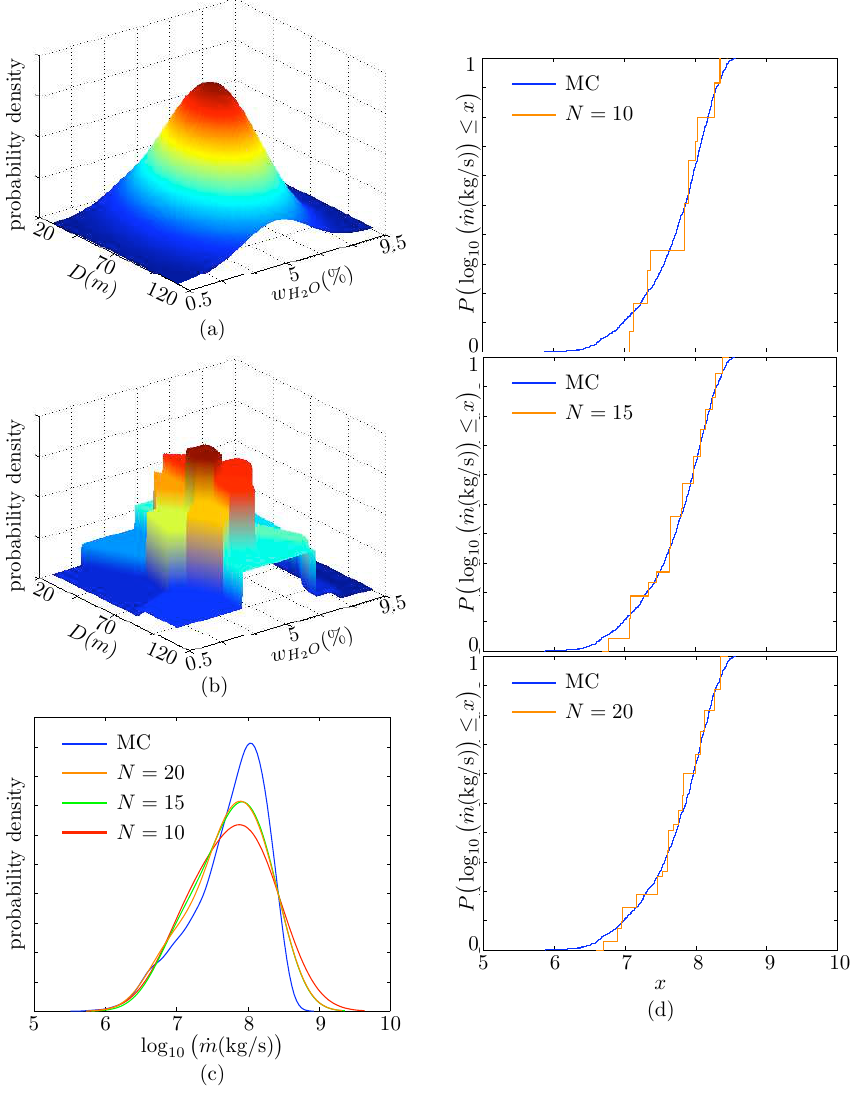
(cid:16) (cid:17) D,w H , while in graph (b) there is its discretization 2 O